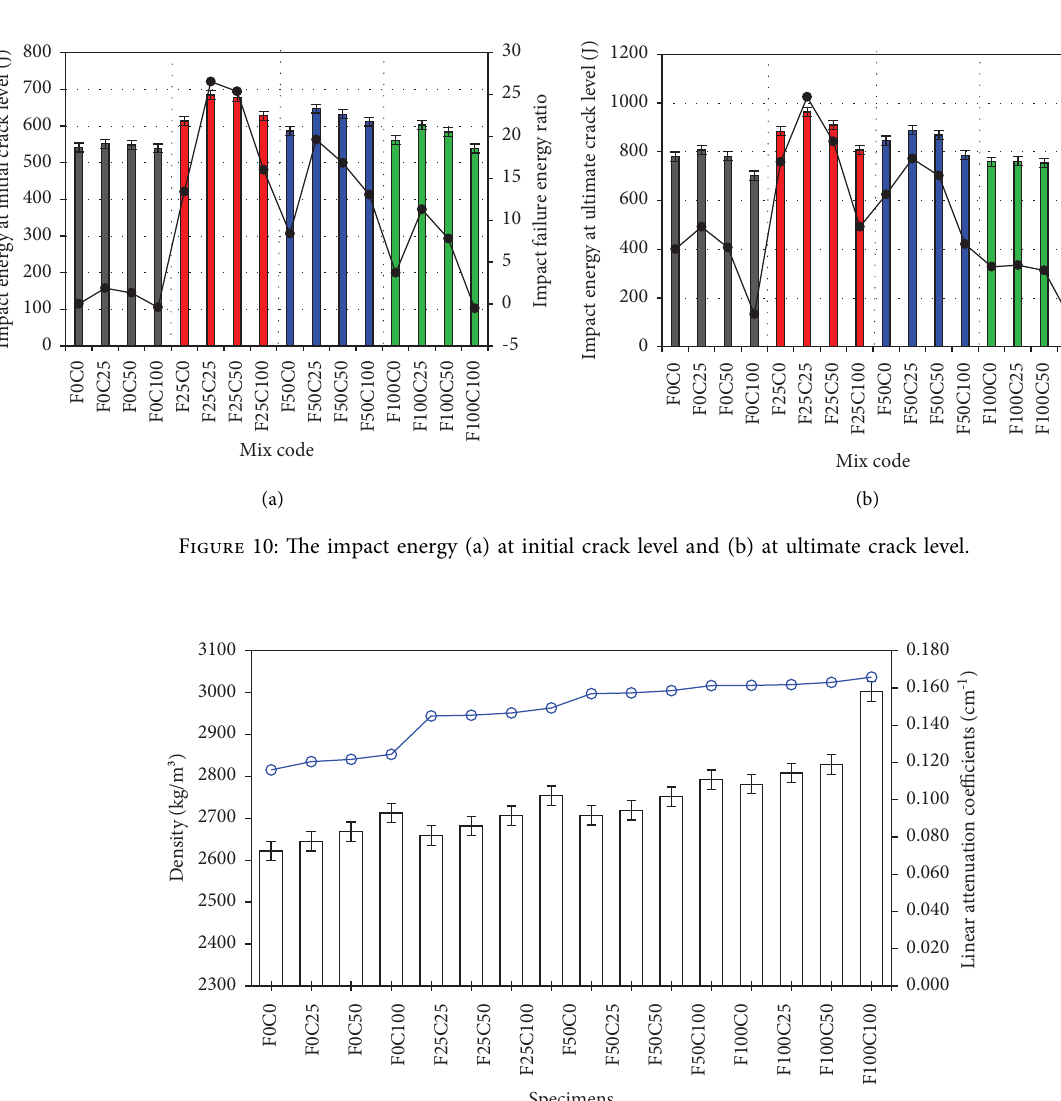
Figure 9: Water penetration